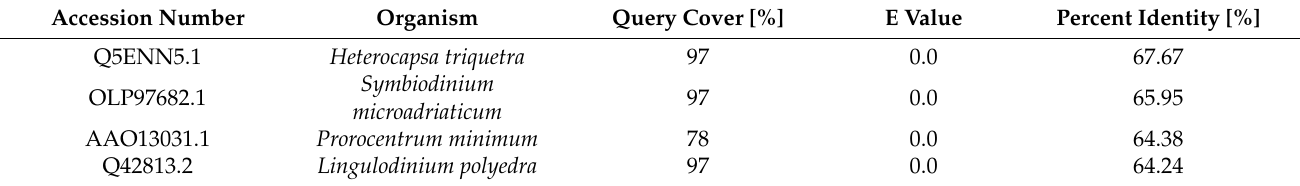
Table 1. Highest scoring homologues of Rhodospirillum rubrum Rubisco among